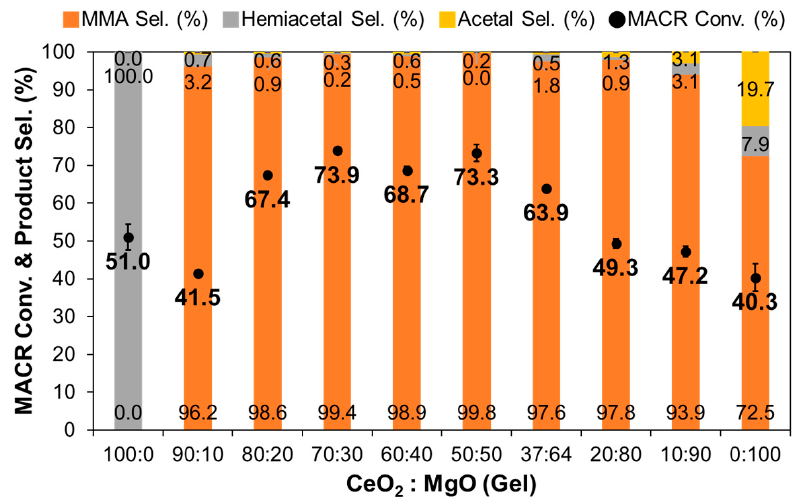
Figure 2. Reaction summaries showing the MACR conversion and product selectivity obtained by by using Au/CeO 2 –Mg(OH) 2 with different Ce:Mg ratios calcined at 750 ◦ C. The results are also using Au/CeO 2 –Mg(OH) 2 with different Ce:Mg ratios calcined at 750 °C. The results are also summarized in Table 1. The reaction was carried out at 80 ◦ C for 1 summarized in Table 1. The reaction was carried out at 80 °C for 1 h.